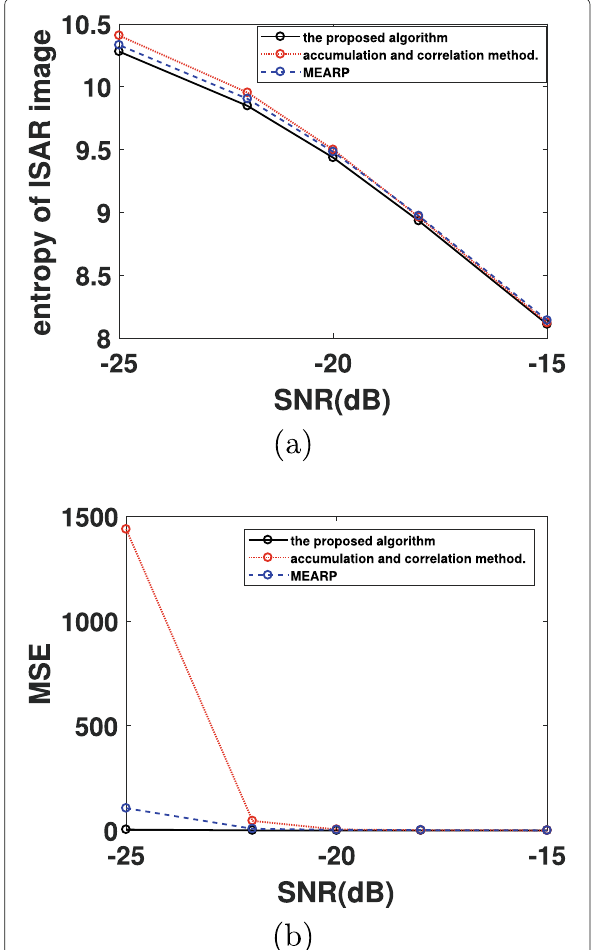
Fig. 10 Results of the Monte Carlo experiments. a The mean entropy of ISAR images obtained from the three methods and b the MSE of the error